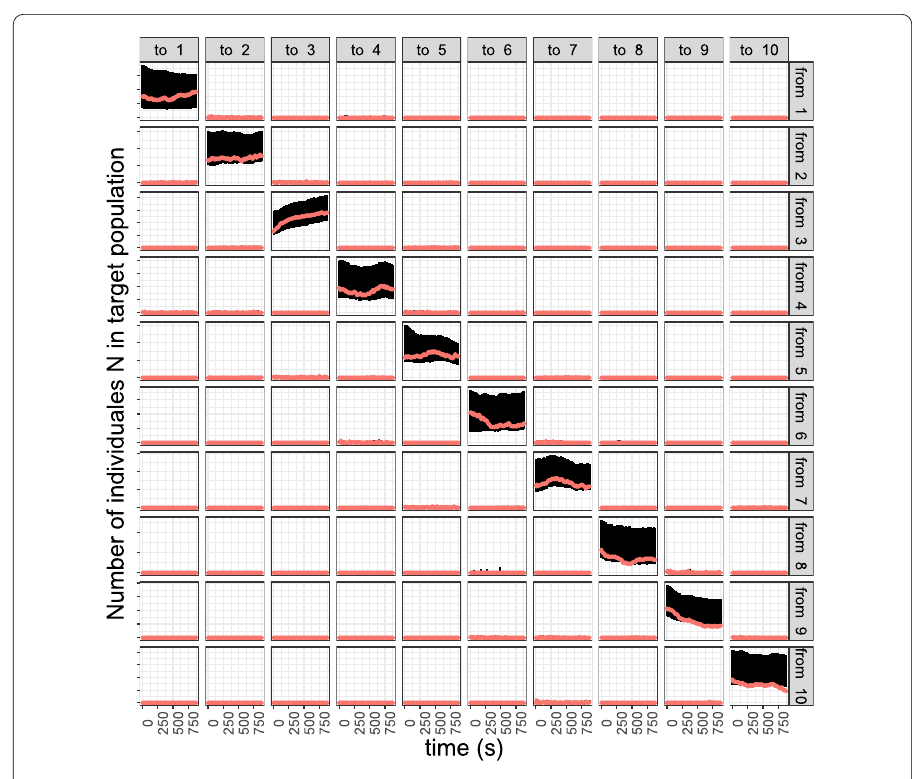
Figure 21 Credible intervals for the OD matrix. Credible intervals (prob = 95%) for OD matrix compared to true values (in red) computed according to the whole module integration with the RSS geolocation model with uniform prior and the beta negative binomial with rb reg = 0.20 and cv reg =